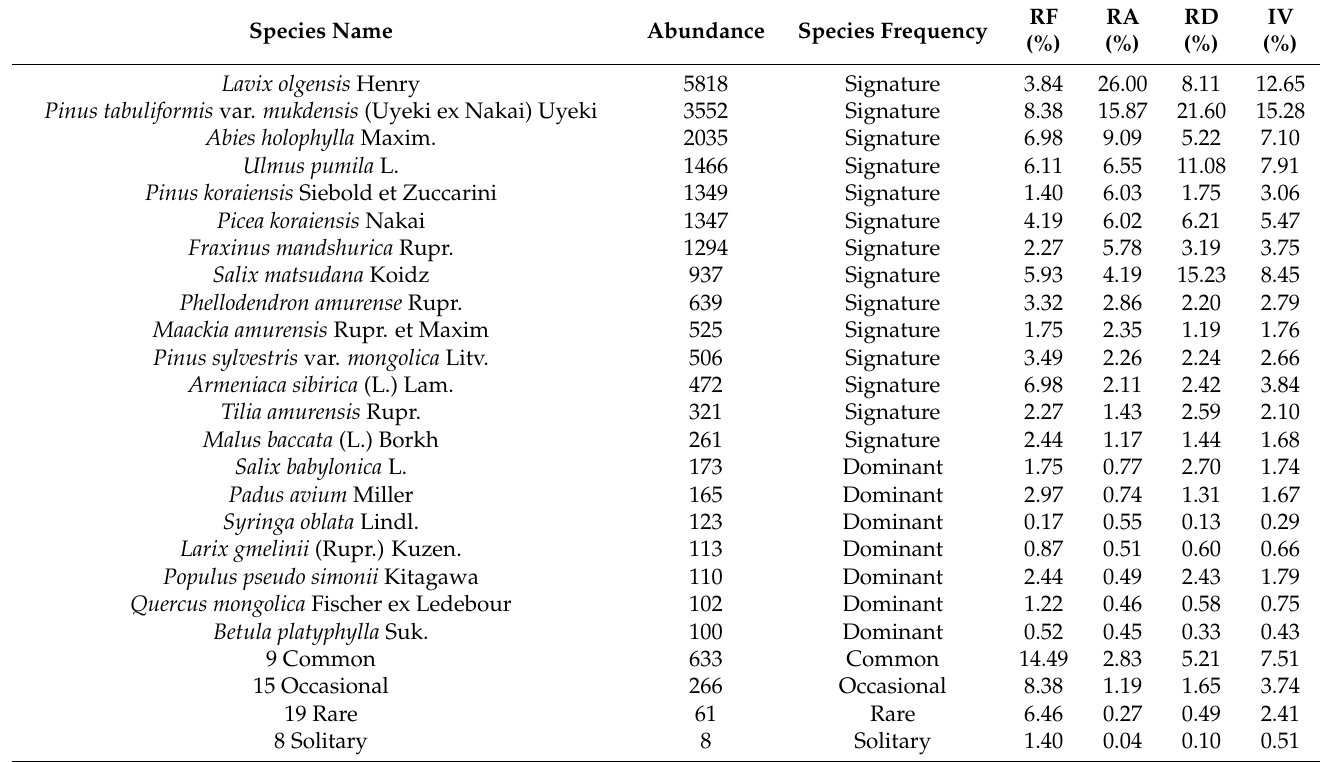
Table 2. Species frequency, relative frequency (RF), relative abundance (RA), relative dominance (RD), and species importance value (IV) in Changchun.